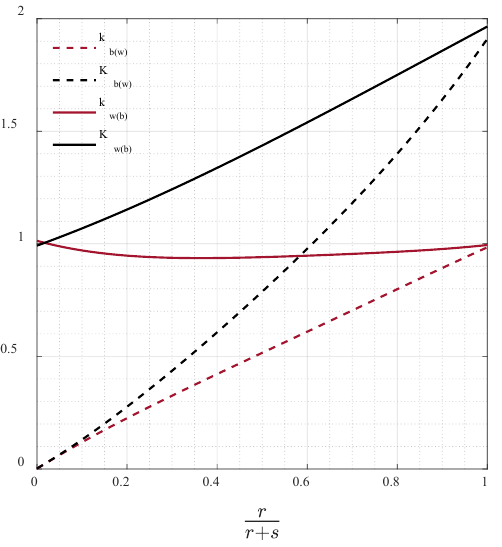
Figure 7. Control surface—interaction factors for fins on cylindrical bodies of circular section [29].